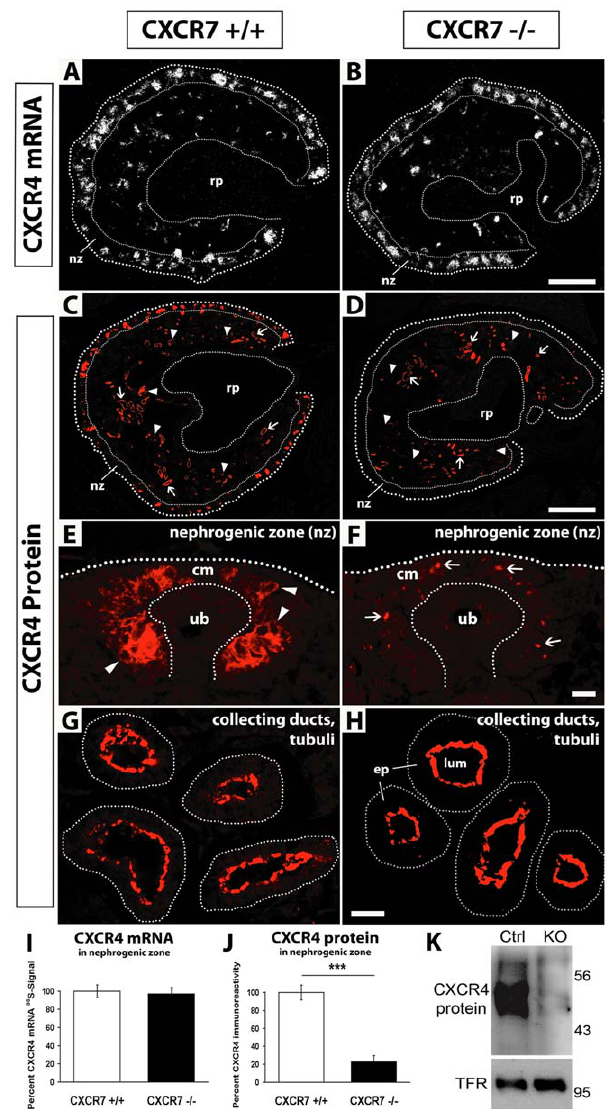
Figure 5. CXCR4 immunoreactivity in CXCR7 deficient kidneys. ( A,B ) In situ hybridizations with a radiolabeled CXCR4 probe show similar CXCR4 expressionpatternsandlabeling intensities inthe E14.5 kidney ofa wildtype and a CXCR7 deficient mutant. ( C,D ) Immunostaining of the CXCR4 protein in E16.5 kidney sections of a wildtype and a CXCR7 mutant littermate show severely reduced immunoreactivity in the nephrogenic zone (nz), in glomerular tufts (arrowheads) but not in tubular structures (arrows) of the mutant. ( E–H ) Higher magnification pictures showing CXCR4 protein signals in wildtype and CXCR7 deficient nephrogenic zone (E,F) and tubular structures (G,H). In the cap mesenchyme (cm) of the CXCR7 2 / 2 embryo (F), CXCR4 immunoreactivity is heavily reduced to single protein signals allocated to the cytoplasm of the mesenchymal cells (arrows). CXCR4 protein signals at the apical site of tubular epithelial cells (ep) are similar in a CXCR7 wildtype (G) and a mutant littermate (H). ( I ) Measurement of CXCR4 mRNA-radiosignal positive area in the nephro- genic zone (see A,B: nz). ( J ) Measurement of CXCR4 immunoreactivity positive area in the nephrogenic zone (see C,D: nz) reveals severe downregulation of the CXCR4 protein in CXCR7 2 / 2 kidney sections (Mann-Whitney U test, p , 0.001). Data represent mean values 6 SEM as percentage of the wildtype group (I,J). ( K ) Western Blot showing CXCR4 protein expression from 22 pooled E14.5 kidneys of control and CXCR7 knockout embryos. Endogenous transferring receptor (TFR) was used as loading control. lum, lumen; rp, renal pelvis: ub, ureteric bud. Scale bars equal 100 m m (B), 200 m m (D) and 10 m m (F,H).